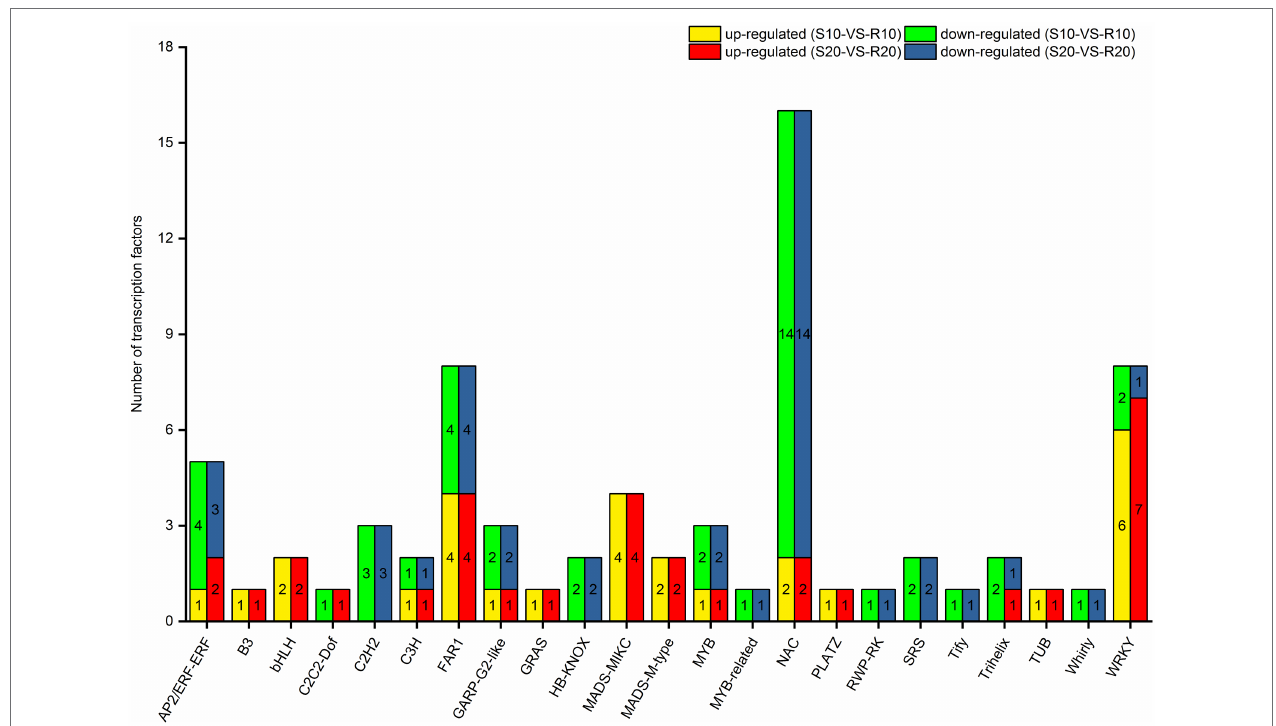
FIGURE 7 | Distribution of differentially expressed transcription factors in triticale leaves infected with Pst